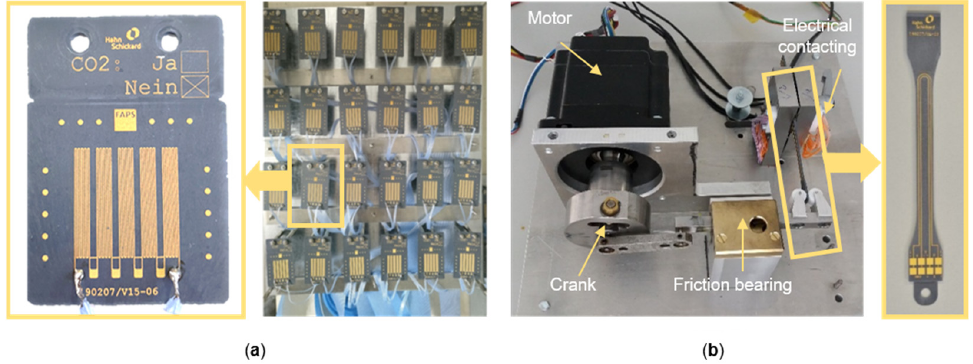
Figure 4. ( a ) Setup for thermal shock tests and the corresponding sample; ( b ) Customized setup for flexural fatigue tests and the corresponding sample.